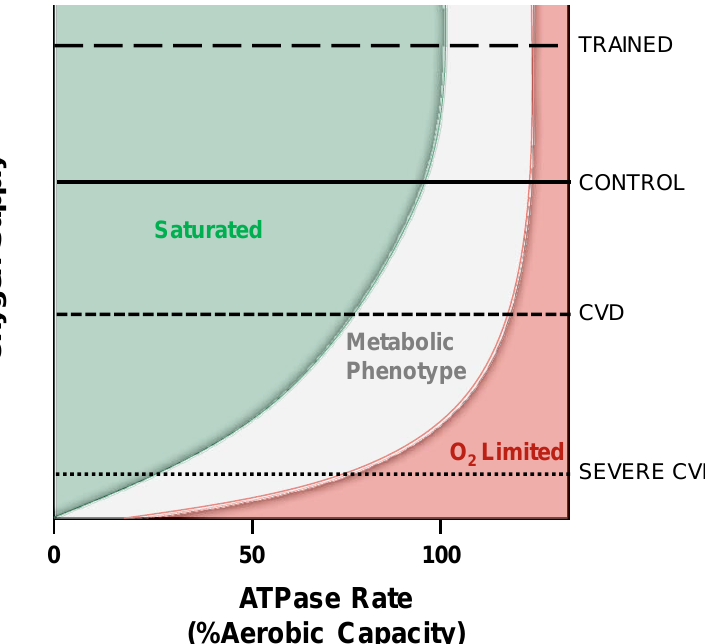
Figure 6. The critical point that limits muscle aerobic respiration varies between metabolic conditions. Within the control condition, oxygen is not limiting until the aerobic capacity is nearly reached and glycolysis affects the measures of MOP capacity inherent to mitochondrial function. As cardiovascular disease (CVD) develops, oxygen supply to muscle is reduced and results in a metabolic phenotype (reduced phosphate potential) at lower workloads that may develop into complete oxygen limitations in severe CVD. For simplicity here, severe CVD includes any disease presenting poor oxygen delivery including PAD, heart failure, COPD, and others. In contrast, exercise training increases mitochondrial fractional volume as well as oxygen delivering capacity and thus falls within a zone where oxygen saturation persists at higher workloads.